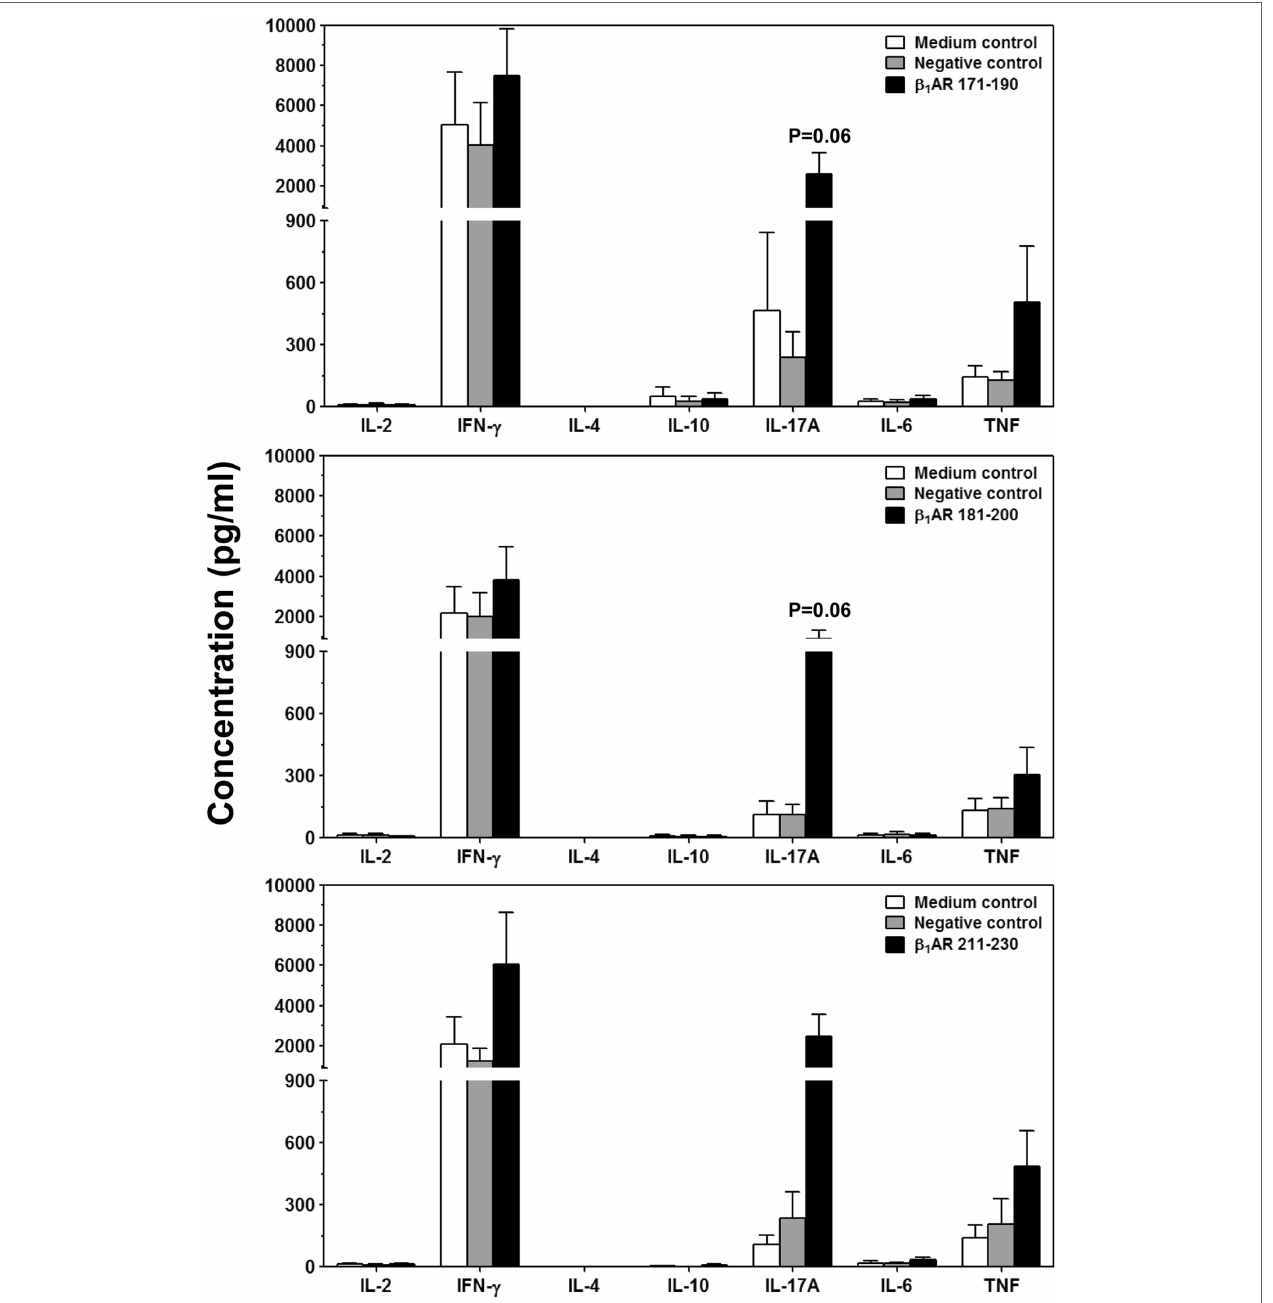
FigUre 5 | Cytokine responses induced by β 1 AR Ac peptides. Lymph node cells (LNCs) were prepared from animals immunized with acetylated or non-acetylated β 1 AR 171–190, β 1 AR 181–200, or β 1 AR 211–230, and after restimulating with or without the immunizing peptides or RNase 43–56/HEL 46–61 (negative controls), culture supernatants were harvested on day 3. Samples were analyzed for indicated cytokines by bead array analysis as described in the methods section. Each bar represents mean ± SEM values derived from four to five individual experiments, with three to eight mice per